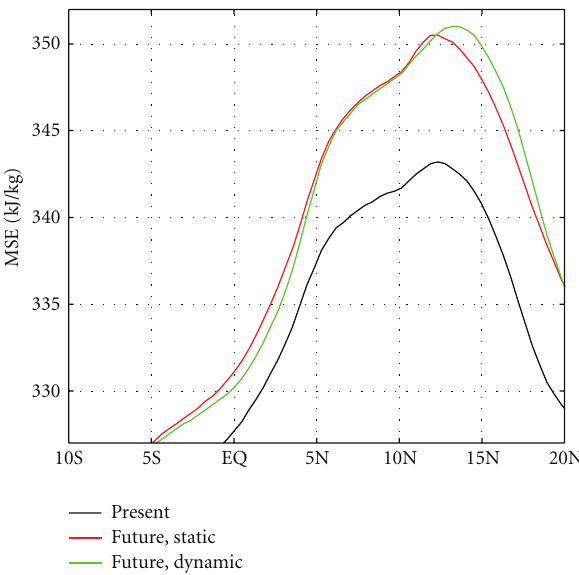
Figure 8: Low-level moist static energy averaged during the peak monsoon month August and over 5 ◦ W-5 ◦